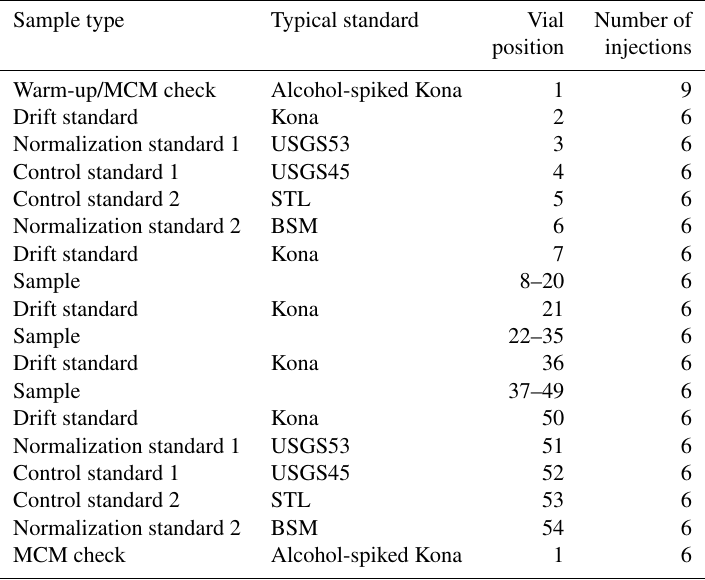
Table 3. Typical sequence structure.